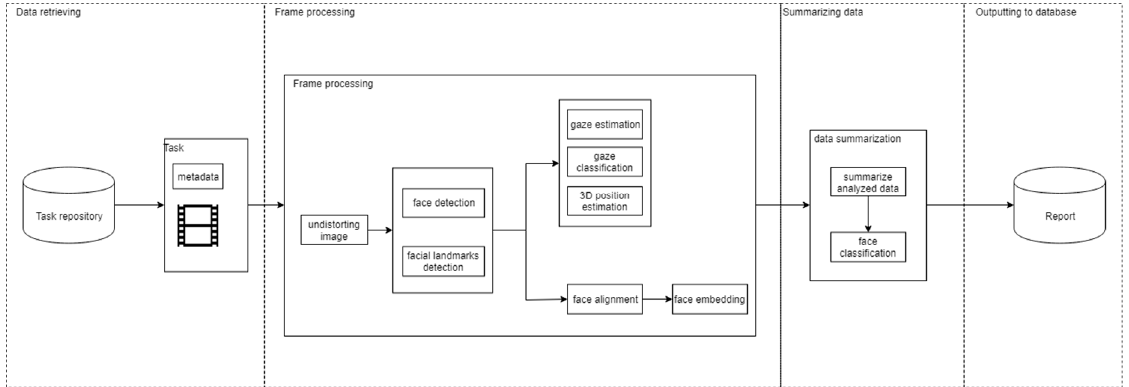
Figure 2. The worker’s AI module pipeline contains four stages: data retrieving, frame processing, summarizing data, and output to the database.